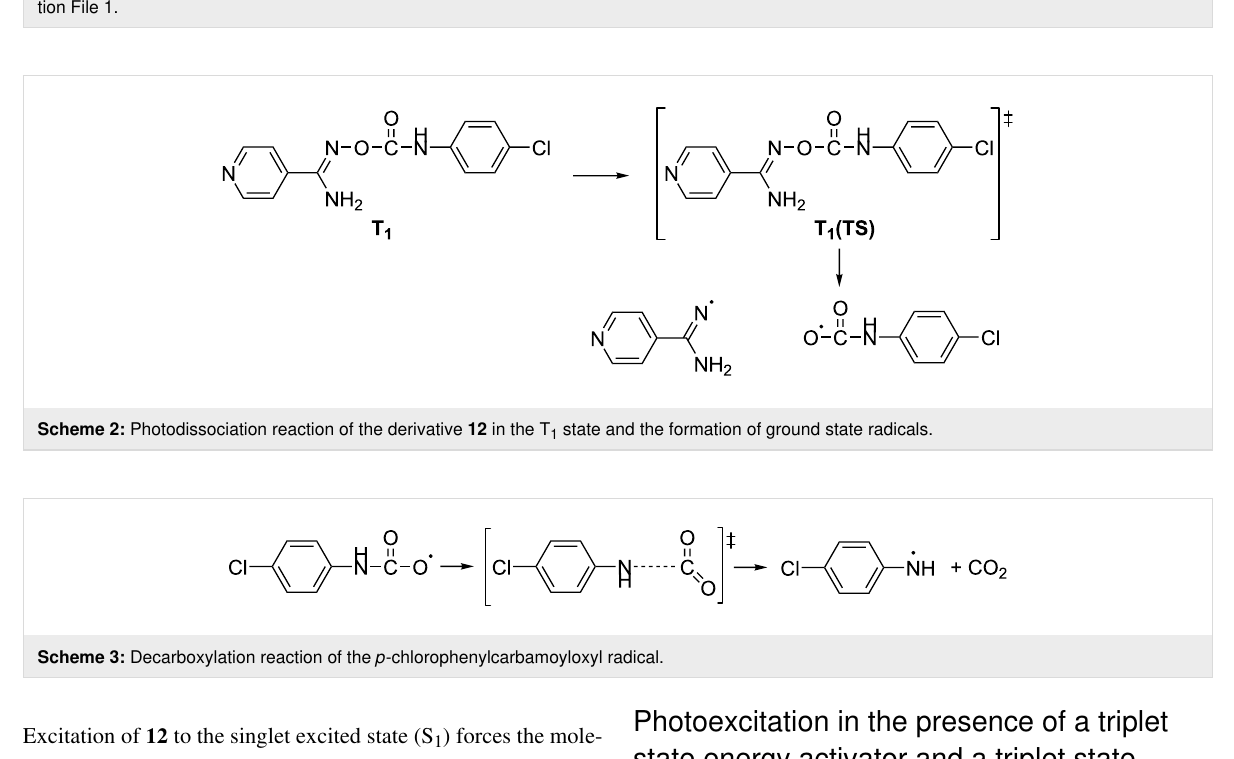
Figure 6: Potential energy curve for the dissociation of 12 in the first excited triplet state, T 1 . For compound 11 see Figure S-8.3, Supporting Informa- tion File 1.